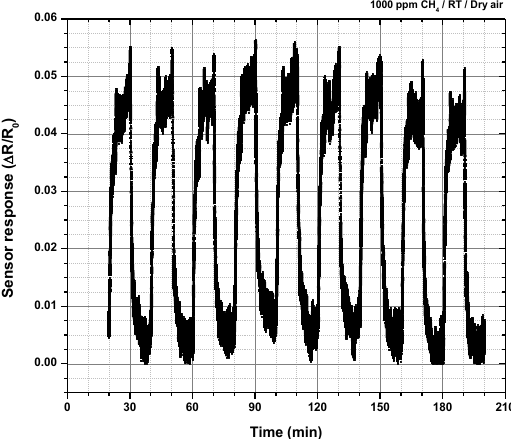
Figure 10. Response of the sensor to 1000 ppm methane in dry air at RT. Measuring cycle: 10 min air flow, followed by 10 min air + 1000 ppm methane flow. Cycle begins at t = 20 min.